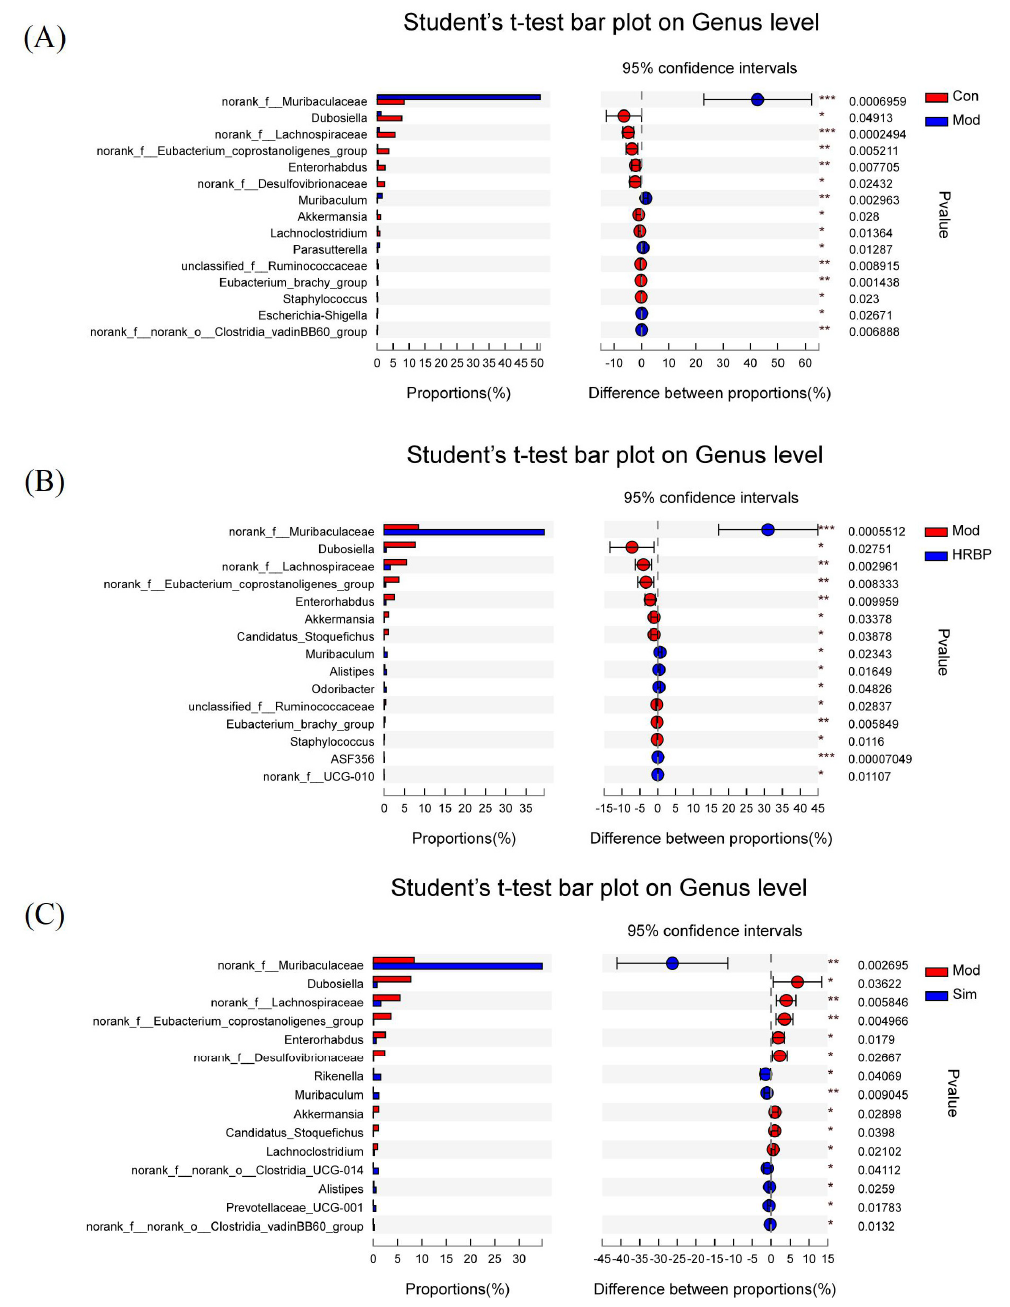
Figure 6. Student’s t -test bar plot of the genus proportions in different groups. ( A − C ) Student’s t -test bar plot of the genus proportions between the Con/Mod group, the Mod/HRBP group, and the Sim/Mod group. * p < 0.05, ** p < 0.01, *** p < 0.001 compared to Mod group. Con, control group fed with normal diet; Mod, model group fed with HFD; Sim, positive control group fed with HFD and treated with simvastatin; HRBP, high dose RBPs group fed with HFD and treated with 600 mg/kg RBPs.